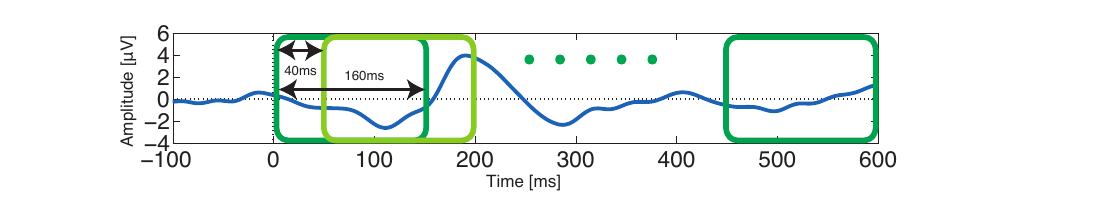
Figure 9. ERP feature extraction procedure: 160ms windows move stepwisely by 40ms.